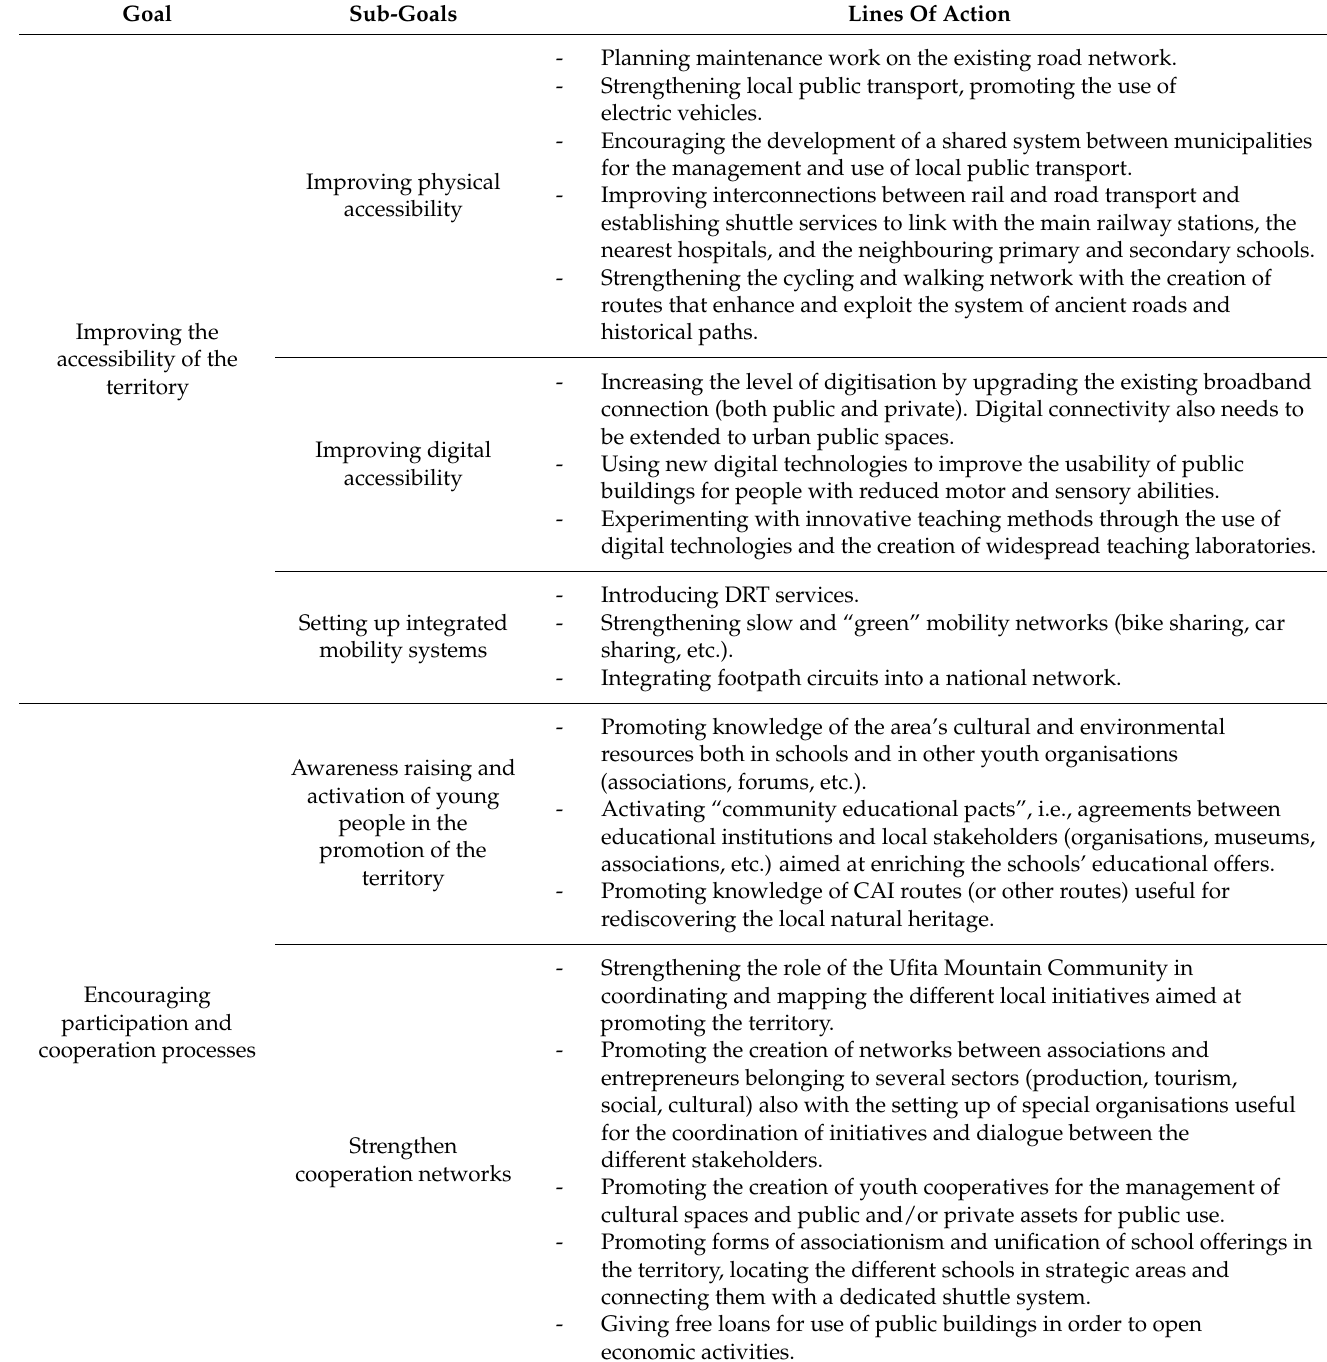
Table A1. Declination of the sub-goals for the strategic axis “Accessibility, services and risk mitigation” into lines of